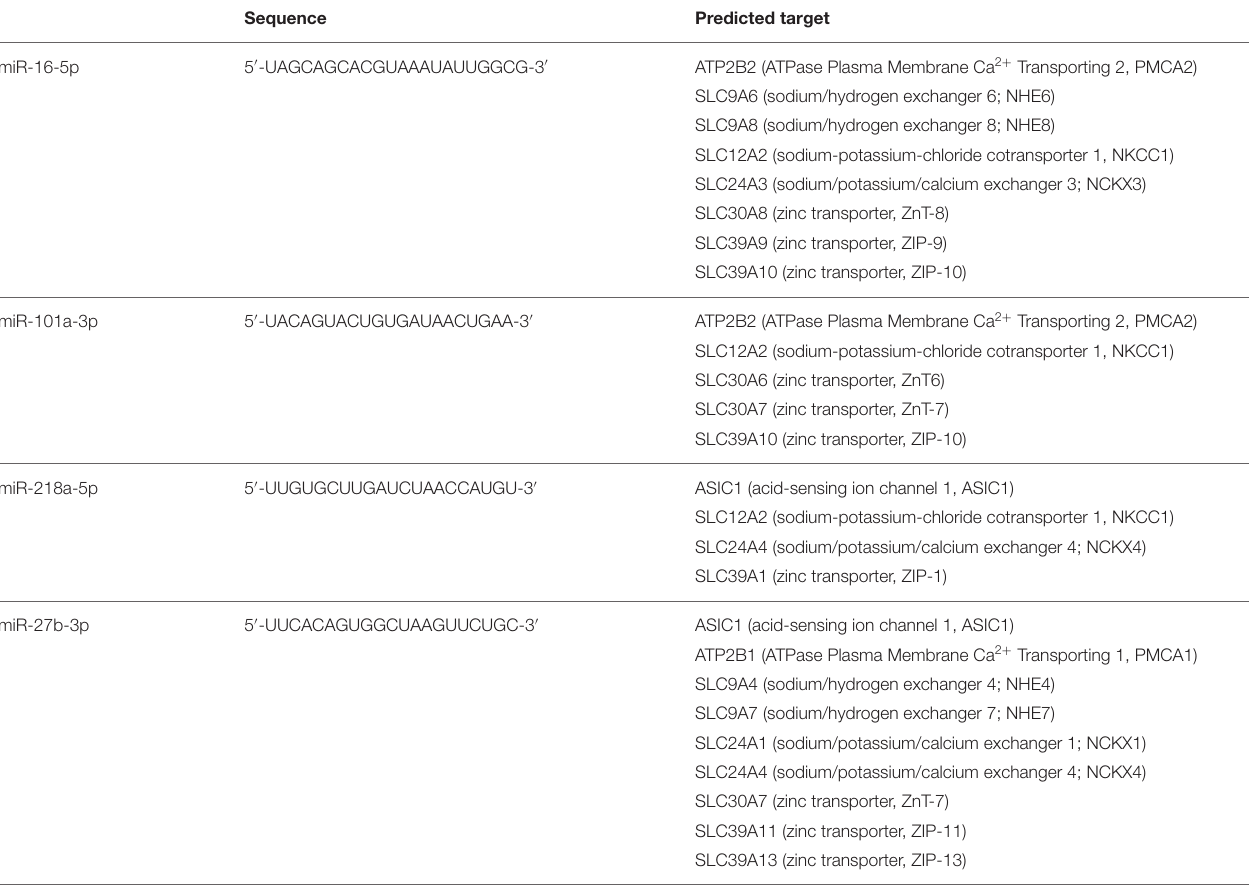
TABLE 1 | List of predicted genes as potential targets of circulating microRNAs modulated by ischemic stroke.